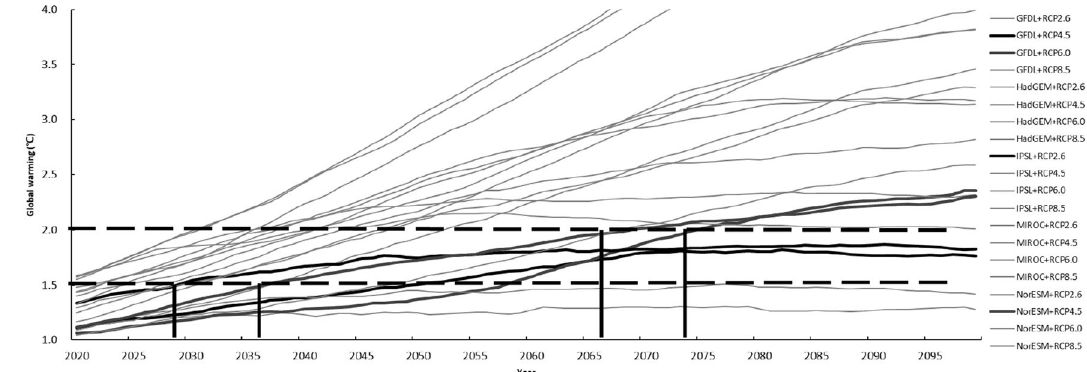
Figure 1. Changes of global temperature of 20 years moving average from 2020 to 2099 simulated by 5 ESMs under 4 RCP scenarios. Note: The black horizontal dashed lines: global warming by 1.5 °C and 2.0 °C; the black vertical solid line: the years when global warming reaches 1.5 °C and 2.0 °C simulated by the selected models and